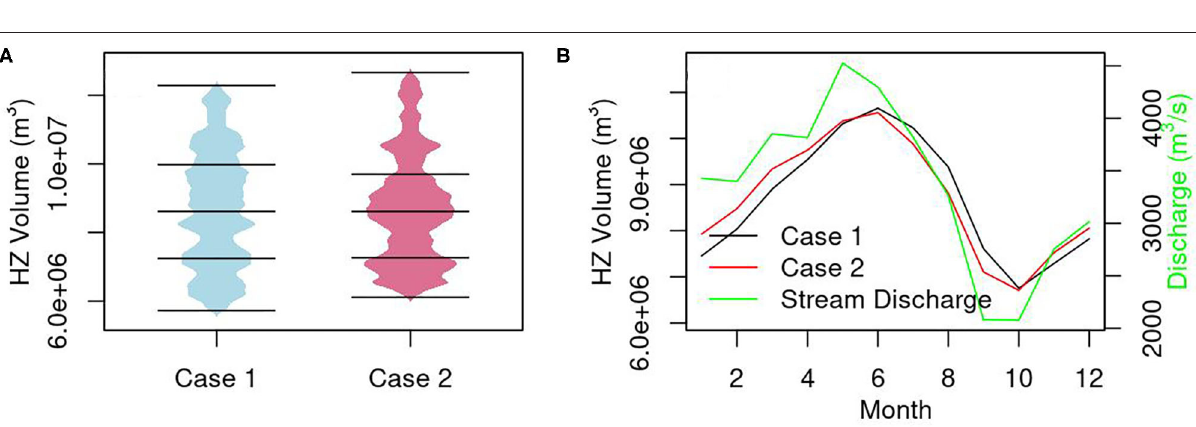
FIGURE 4 | Temporal distribution of HZ volume estimated from the PFLOTRAN simulations (A) and seasonal change of HZ volume and stream discharge (B) . The solid lines in (A) show the quantiles of the HZ